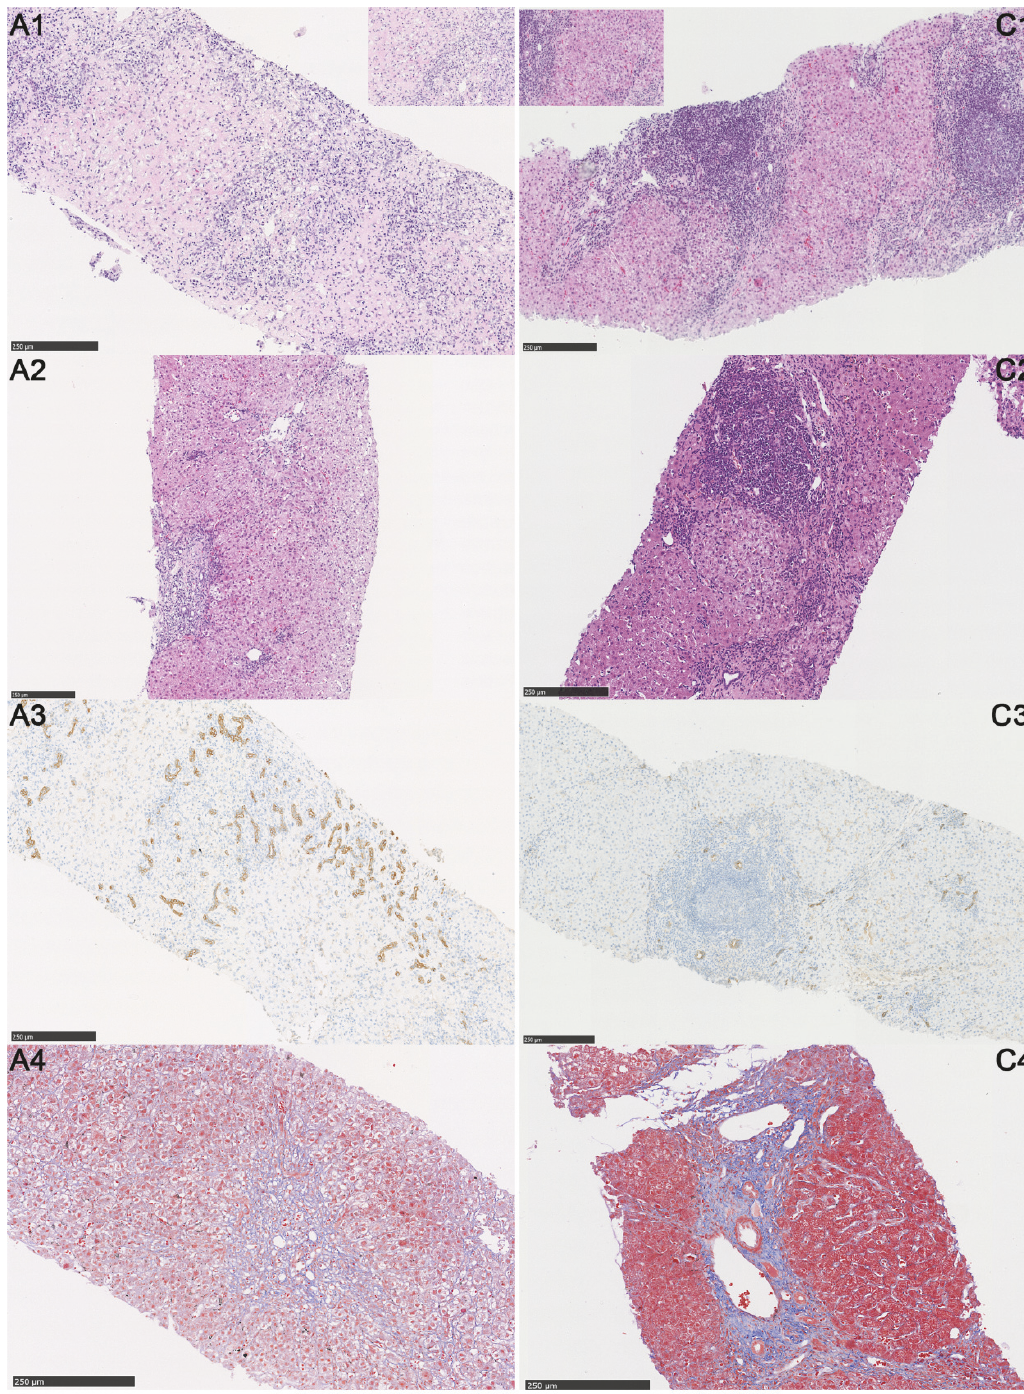
Figure 2: Histological features of A-AIH and C-AIH. A-AIH (A1–4) and C-AIH (C1–4): A1, C1: A1 shows multiacinar and centrilobular necrosis in A-AIH, which is uncommon in C-AIH (H&E, × 200, small pictures emphasized the typical areas in the big pictures); A2, C2: the main manifestation of A-AIH is cellular swelling, ballooning change, and lobular inflammation accompanied by mild interface inflammation; however, C-AIH often has moderate-to-severe interface inflammation caused by lymphoplasmacytic infiltration (H&E × 200); A3, C3: CK7 staining showing regeneration of cholangiocytes due to the multiacinar necrosis of hepatocyte in A-AIH. However, bile duct regeneration was less likely to be found in C-AIH (CK7, × 200); A4, C4: blue staining shows fibrosis in the portal area; fibrous septa were found in the chronic group but not the acute group (Masson trichrome staining, ×